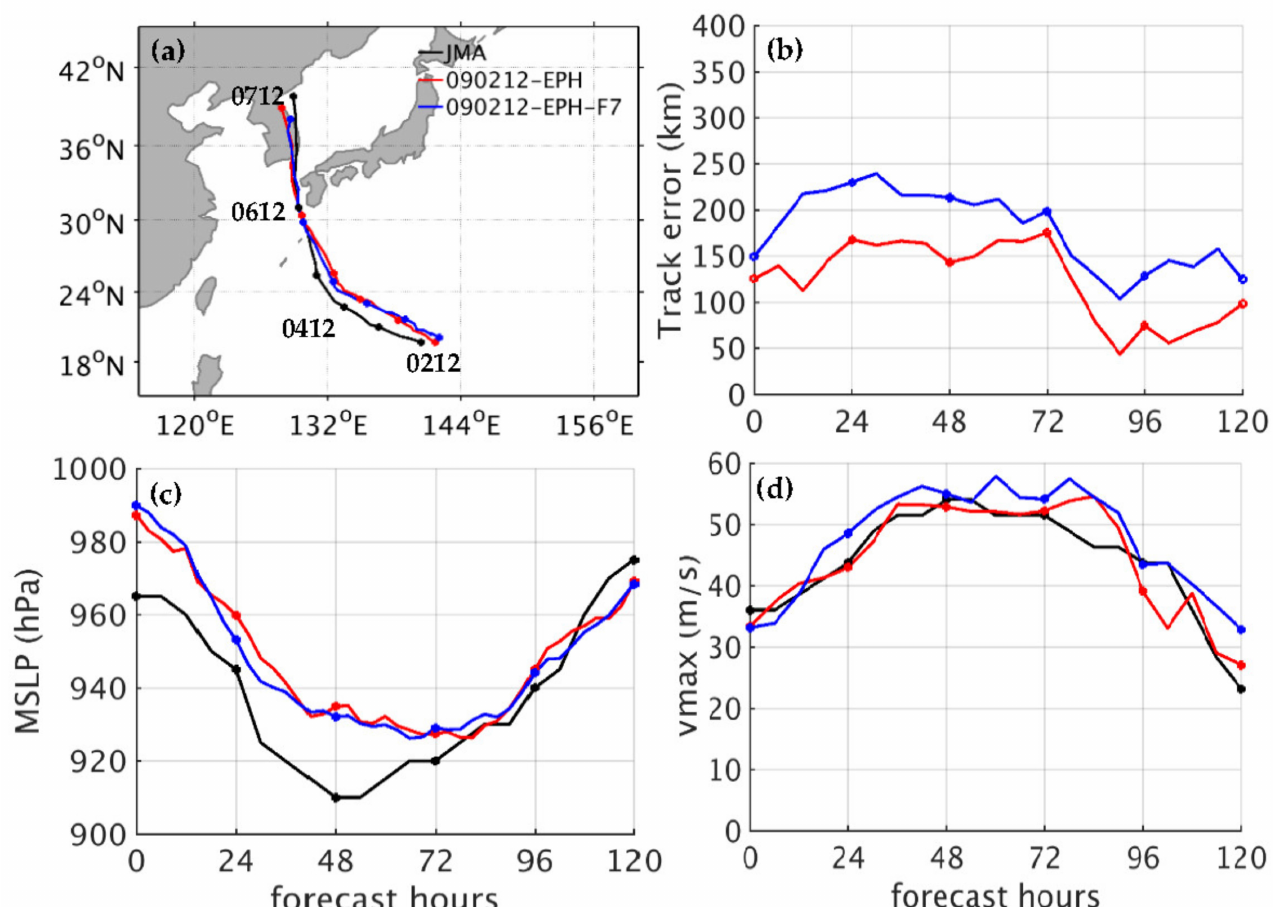
Figure 13. ( a ) Simulated tracks for EPH (red) and EPH-F7 (blue) and the best tracks from JMA (black). ( b – d ) as in ( a ), but for the ( b ) track errors (in km), ( c ) MSLP (hPa), and ( d ) maximum wind speed (V max in m s − 1 ), respectively. Circle symbols mark the typhoon centers every 24